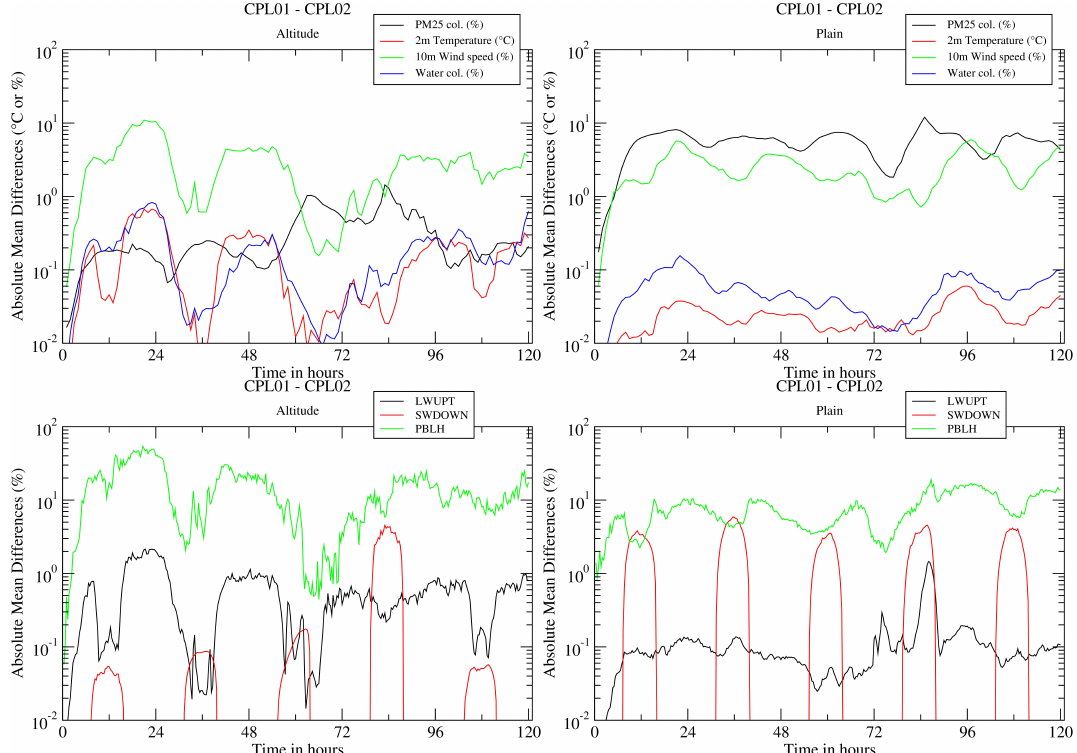
Figure 8. Evolution of absolute values differences in % (except the temperature) from 27 November 00:00 UTC to 02 December 00:00 UTC (120 h) of relevant variables between CPL01 and CPL02 simulations to emphasize the role of PM emissions on meteorology at local scale. Two areas are targeted over the GRE0011 domain: (i) Altitude (left) for surface pressure below 750 hPa and (ii) Plain (right) for surface pressure above 900 hPa. On the top PM2.5 col. and Water col. are respectively the total column of PM2.5 and water vapor mixing ratio, 2 m temperature is the 2-meters temperature, 10 m wind speed is the horizontal 10-meters wind speed. At the bottom LWUPT is the instantaneous upwelling longwave flux at the top, SWDOWN is the downward short wave flux at ground, PBLH is the PBL height. See Appendix B for the detail of calculations for the differences between